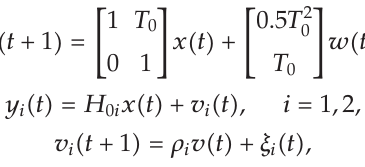
Figure 14: The curve of position errors e 1 (cid:5) t (cid:6) (cid:8) (cid:11) x Kalman